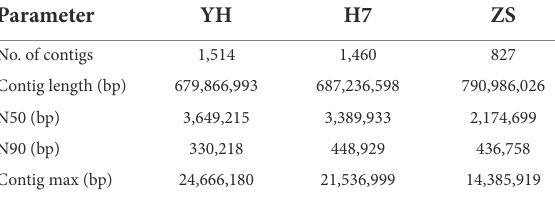
TABLE 1 Summary of three C. mollissima genomes